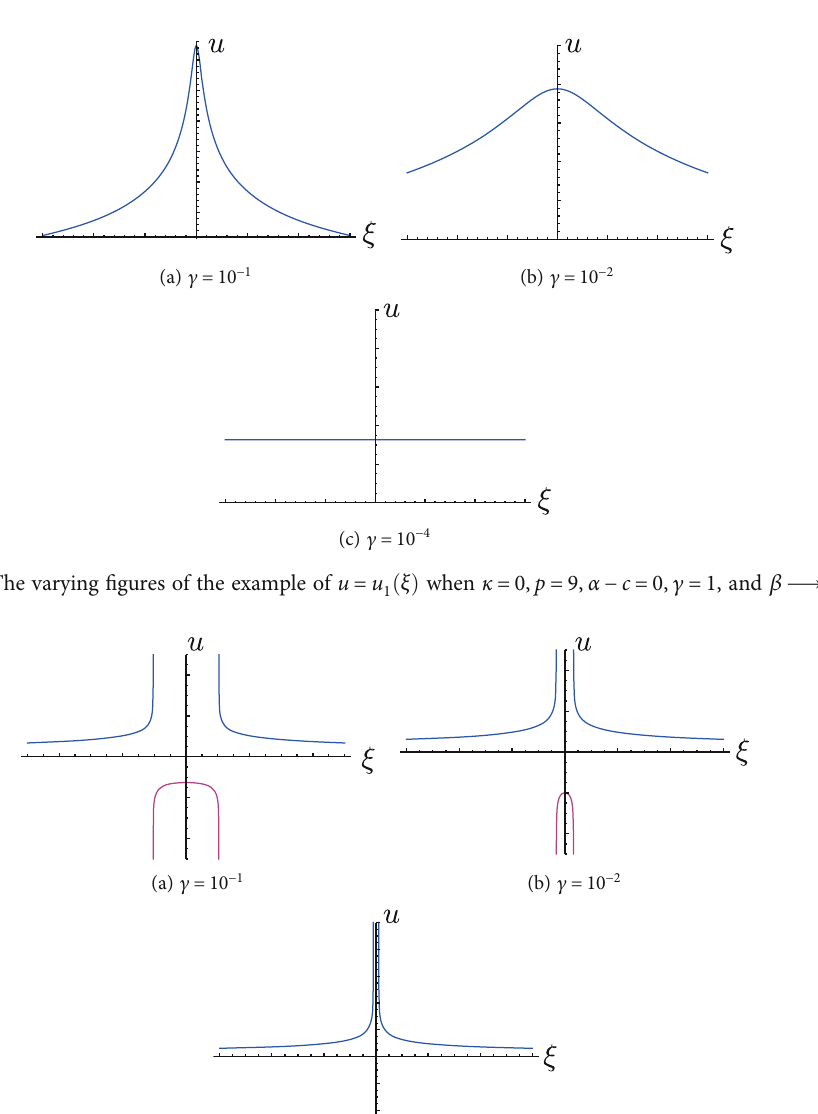
Figure 4: The varying fi gures of the example of u = u